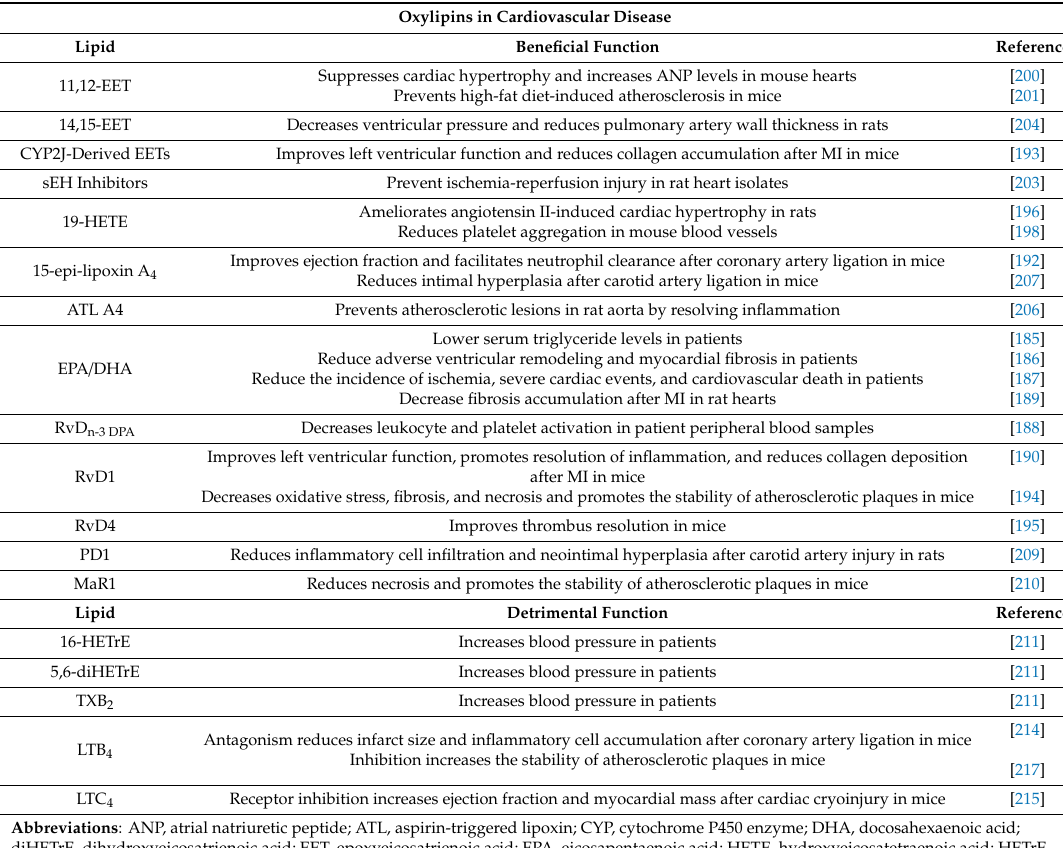
Table 1. Specific oxylipins and their functions in cardiovascular disease.